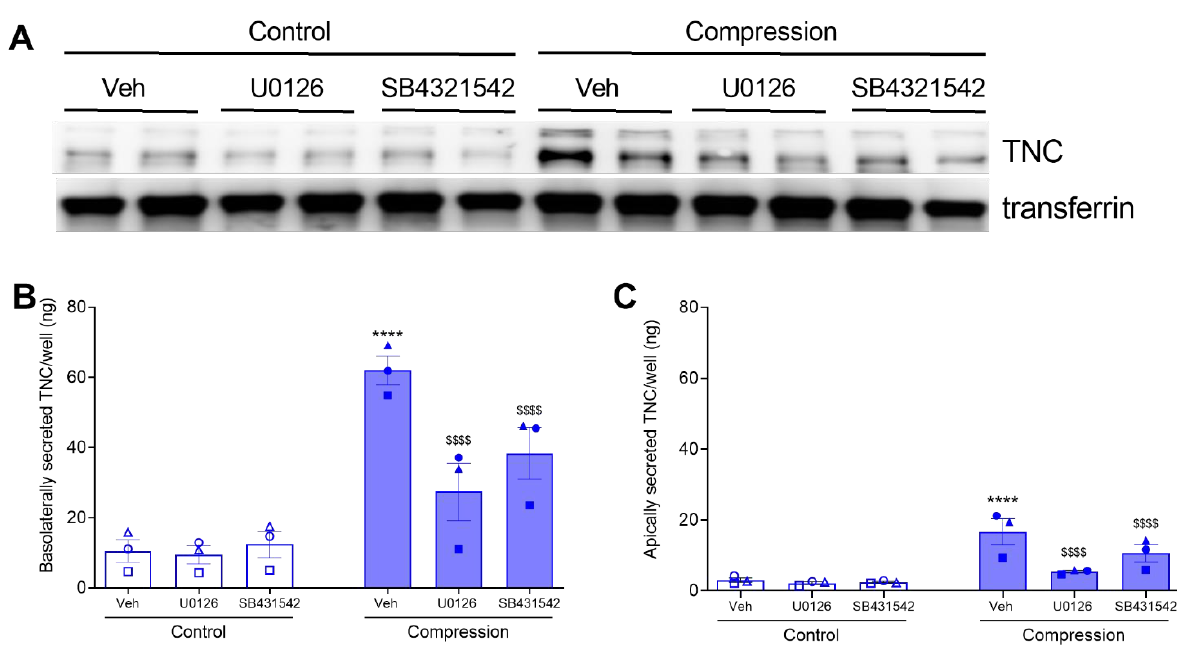
Figure 3. Compression-induced TNC secretion depends on TGF- β receptor and ERK pathways. TNC secreted by HBE cells at 24 h post-compression, in the presence or absence of U0126 or SB431542. Representative Western blot of three independent experiments shows the detection of basolateral secretion of TNC. Transferrin was detected as a loading control ( A ). Secreted TNC were detected by ELISA in the basolateral conditioned media ( B ) and in the apical washes ( C ) (mean ± SEM, 3 non-asthma donors). **** p < 0.0001, significantly different from vehicle control; $$$$ p < 0.0001, significantly different from vehicle with pressure, analyzed by two-way ANOVA with Bonferroni’s post-hoc test. Each symbol represents each of the three donors. The open symbols represent control condition, and the closed symbols represent compressed condition in non-asthmatic HBE cells (blue symbols; B , C